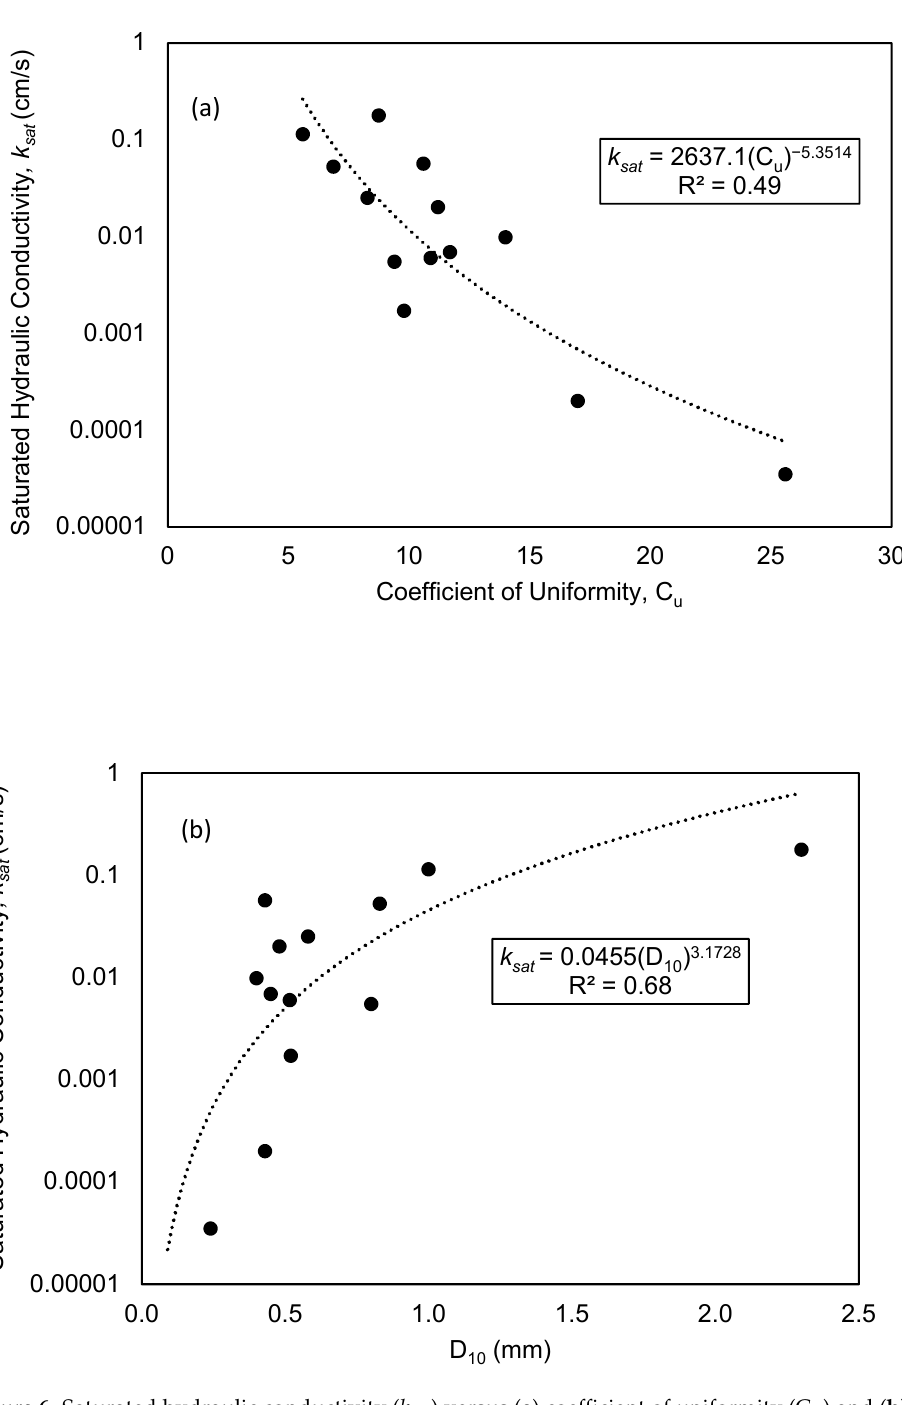
Figure 6. Saturated hydraulic conductivity ( k sat ) versus ( a ) coefficient of uniformity (C u ) and ( b ) D 10 for RAP from the literature [11,12,17,18,30,32,34].